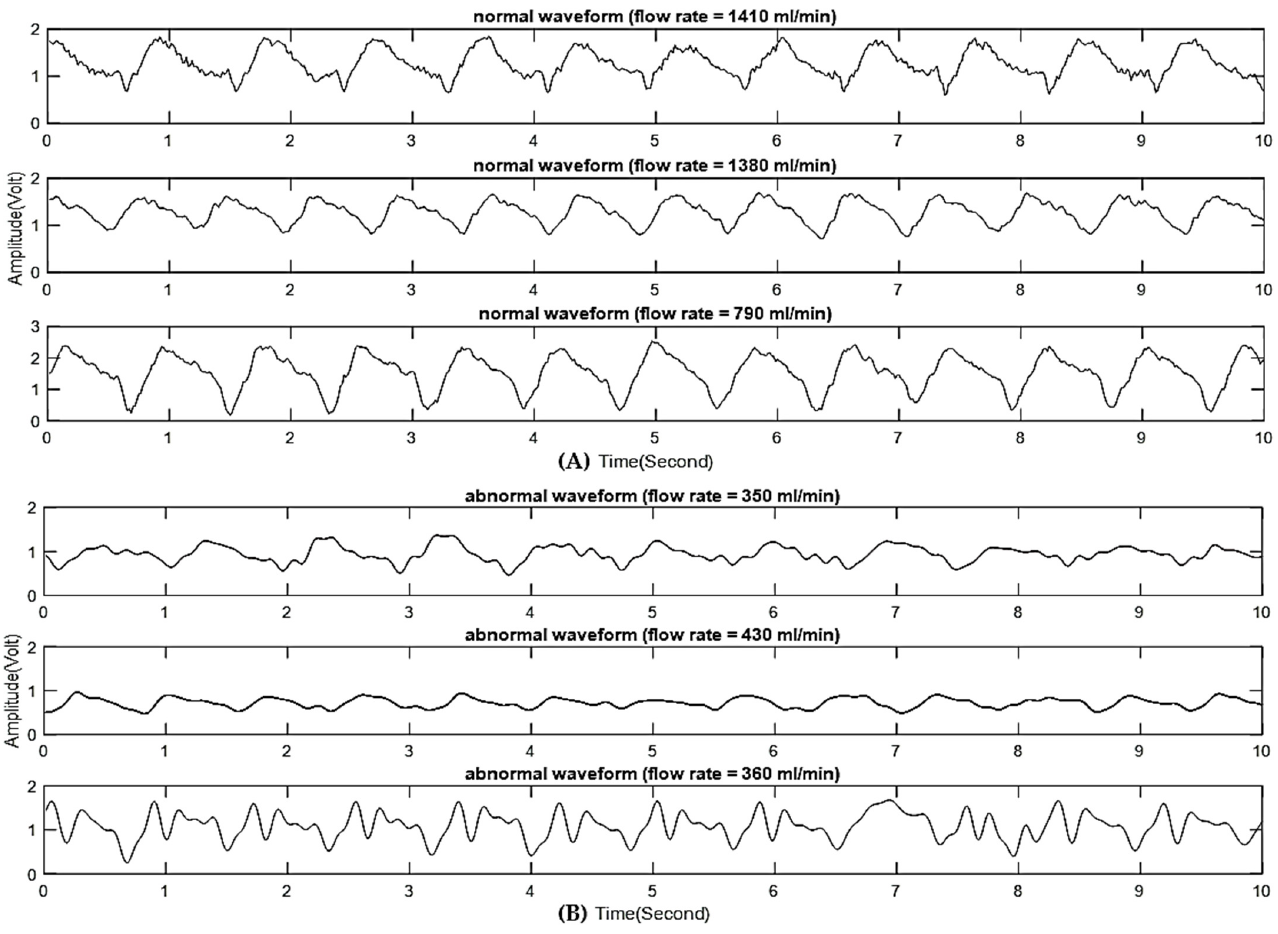
Figure 2. ( A ) Baseband signals of normal AVF with stable and consistent VWM waveforms. ( B ) Baseband signals of abnormal AVF with unstable and superimposed oscillations on VWM waveforms.